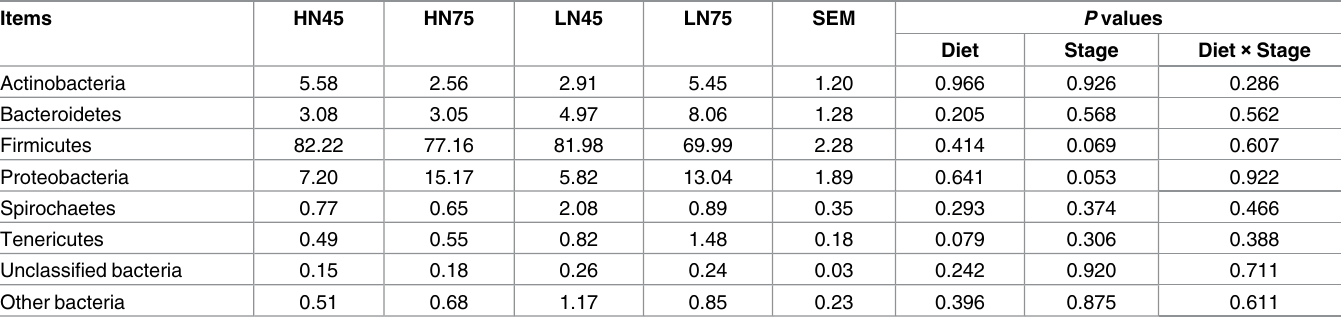
Table 3. Composition of ileal bacterial communities at the phylum level in Huanjiang mini-pigs at different pregnancy stages (%). Items